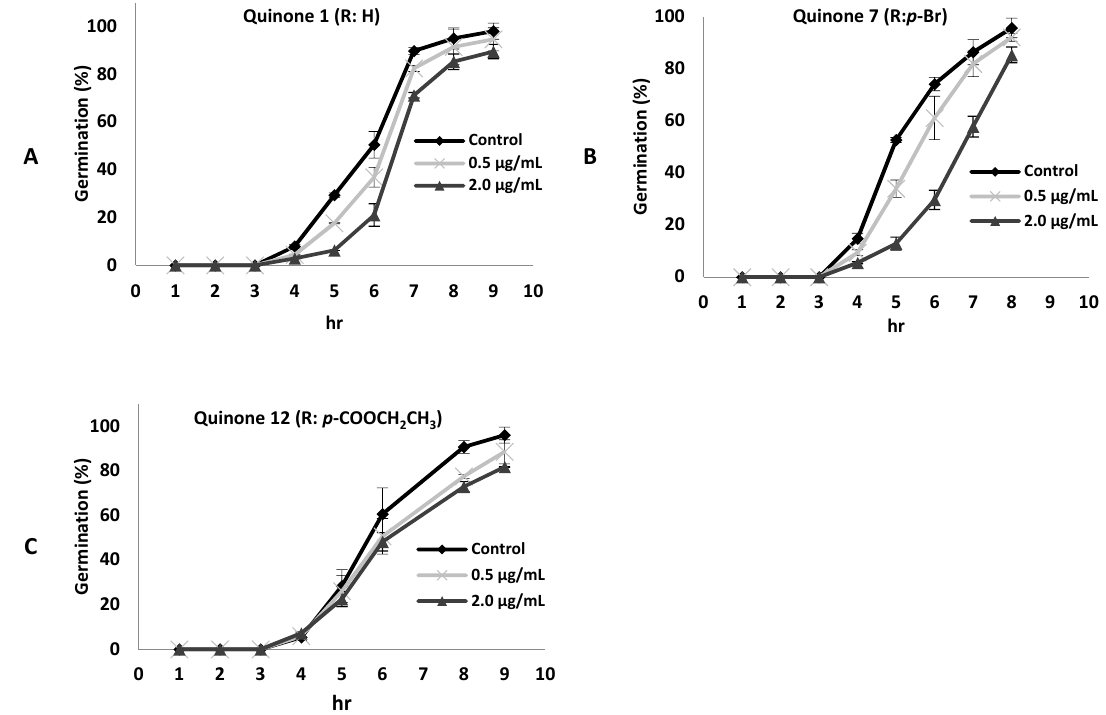
Figure 3. Effect of compounds 1 ( A ), 7 ( B ), or 12 ( C ) at different concentrations on B. cinerea germination. Data represents mean ± standard deviation of three independent experiments.